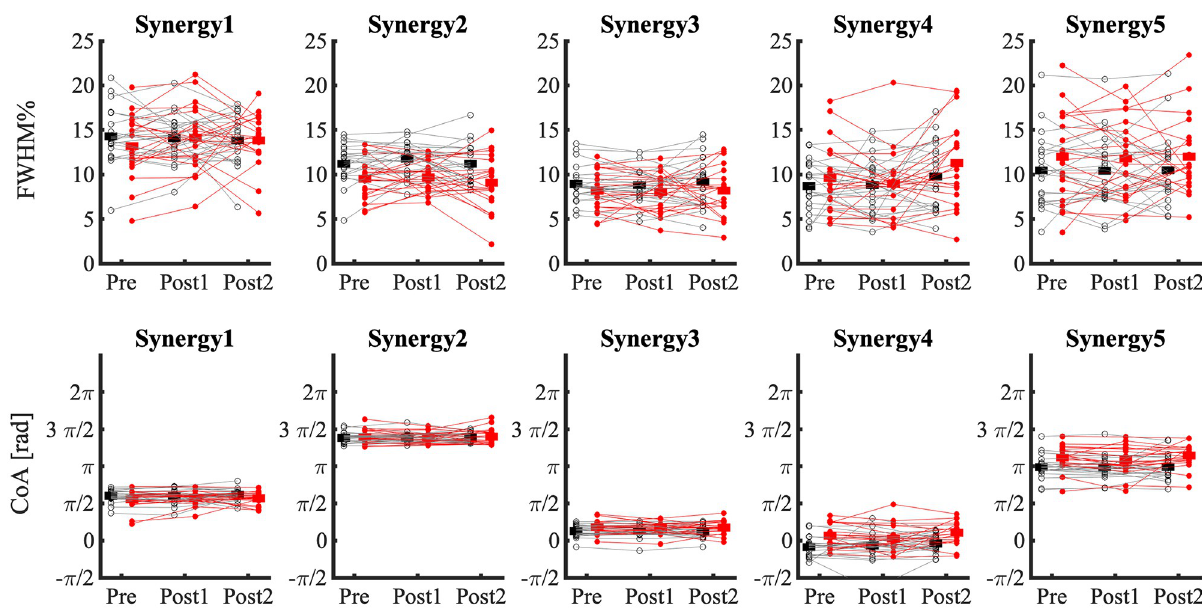
Fig 9. FWHM and CoA of five synergies, in narrow-base and normal walking at time-points Pre, Post1, and Post2. Thin lines represent individual subject data. Thick horizontal lines indicate means over subjects. Black, normal walking; red, narrow-base walking.